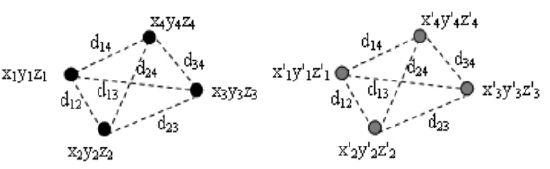
Equations (9) and (10), will always remain constant be- cause of the rigid body structure. The new positions of the projections of markers are known from the detector plate but the new positions of the markers are not known. In this proposed system, the new positions of the shifted mark- ers are estimated from an iterative numerical optimization technique which minimizes the differences between the known relative distances among the marker positions and the corresponding relative distances among the estimated markers positions.